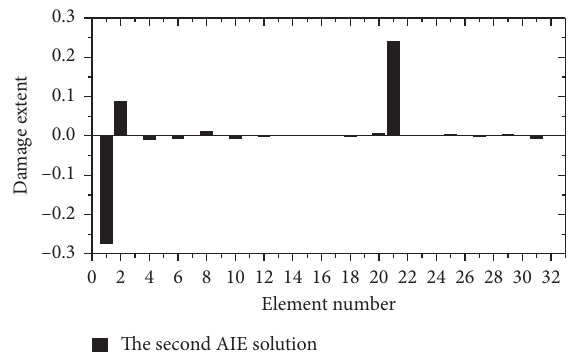
Figure 13: Damage assessment result by the second AIE when element 21 is